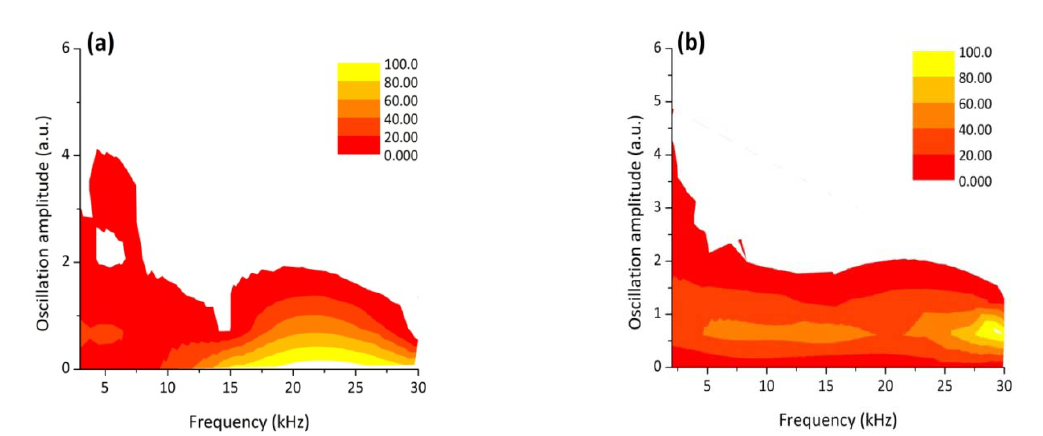
Figure 4. DWT oscillation frequency maps calculated for each joint segment (the color scale indicates the distribution in % for each frequency band): zone (a), (b) and (c) indicate three sectors of the